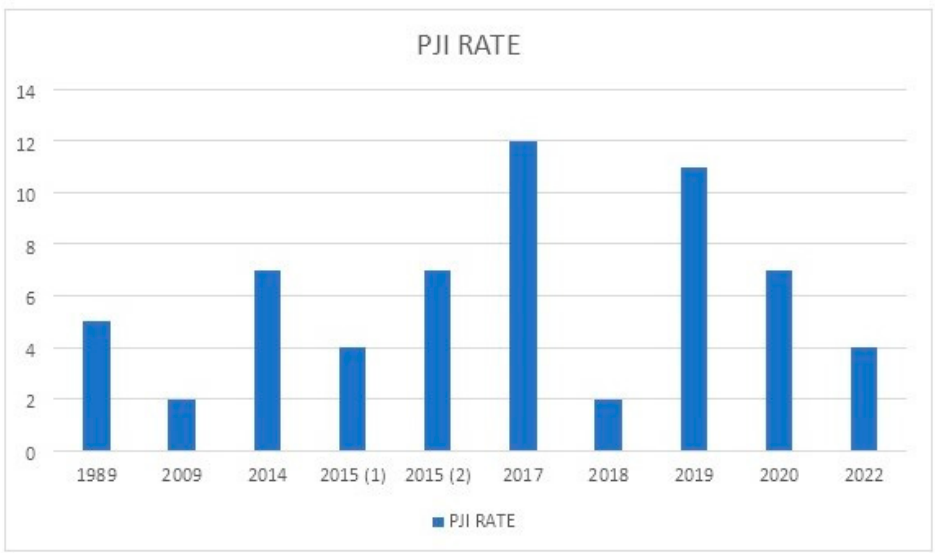
Figure 3. Rates of periprosthetic joint infection (PJI) after total knee arthroplasty (TKA) in people with hemophilia (PWH) from 1989 to 2022. In 2015 there were two articles [(1) and (2)].